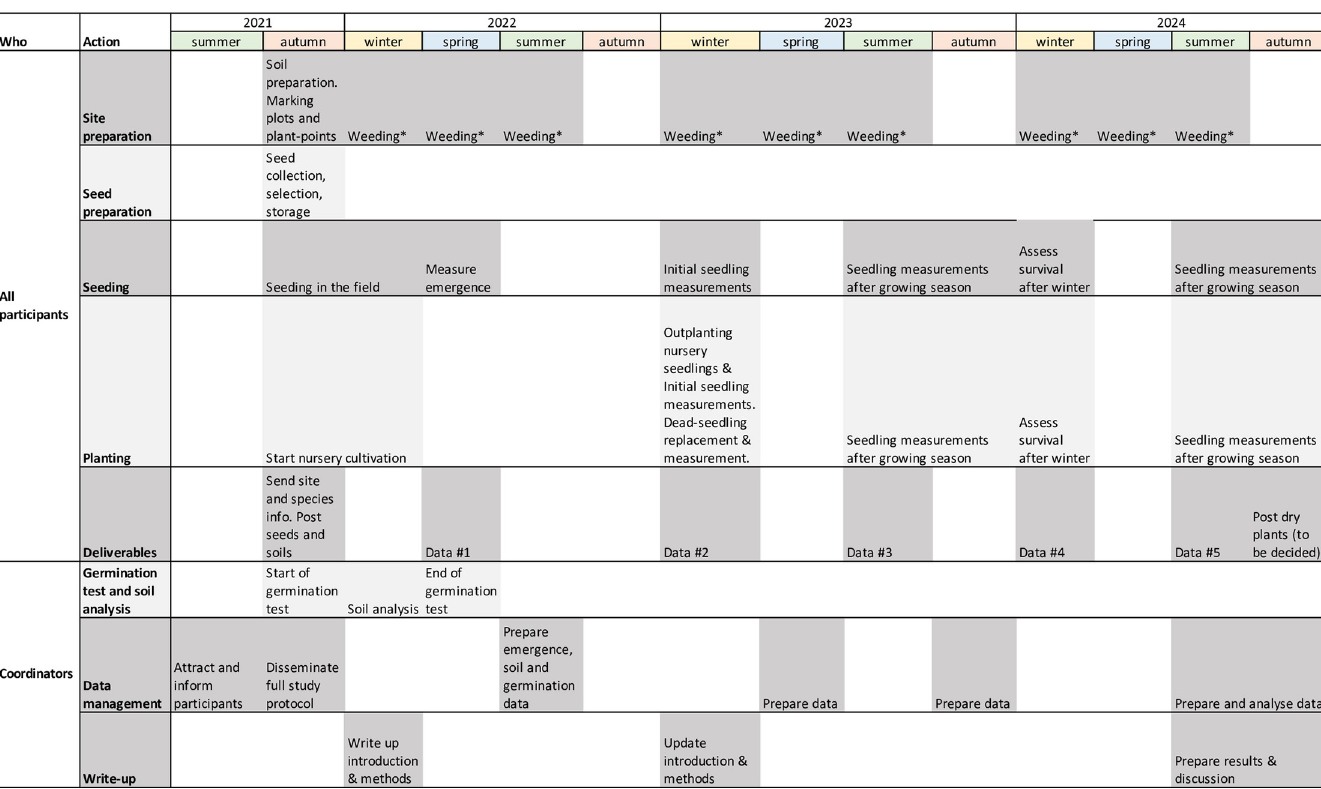
Fig 6. Timeline for the experiment. The exact timing of seed collection, seeding, outplanting, weeding, and measurements will need adjustment to local phenology and must be decided by participants. � Weeding will be done when > 80% of the plots are covered by herbs.